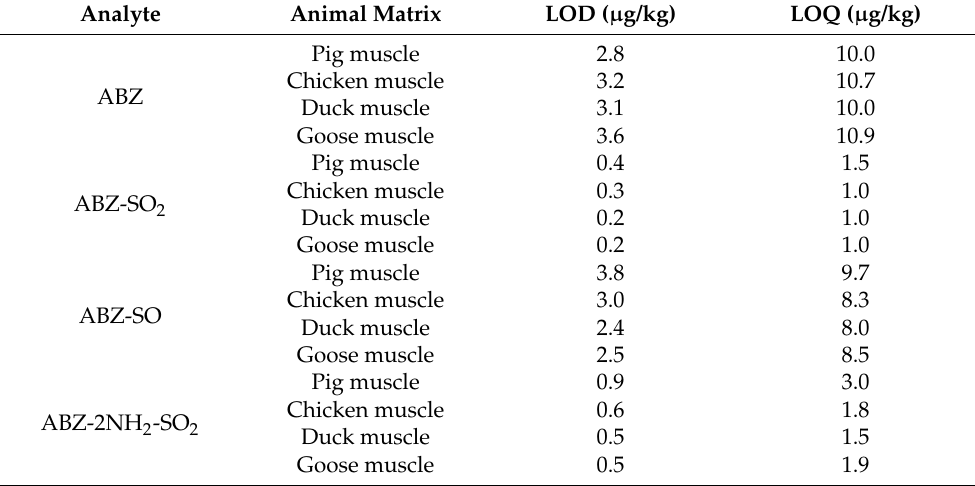
Table 1. LODs and LOQs of ABZ, ABZ-SO 2 , ABZ-SO and ABZ-2NH 2 -SO 2 in pig and poultry